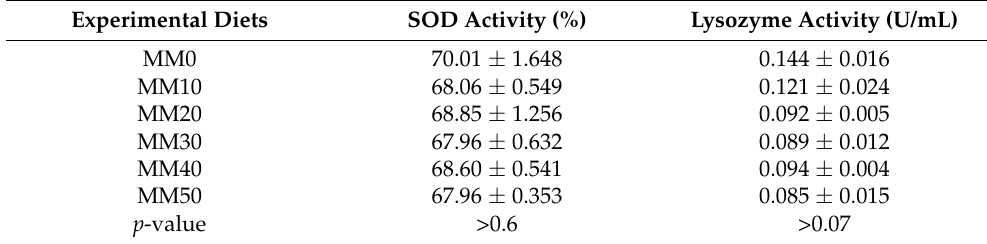
Table 7. Lysozyme activity and SOD of olive flounder fed the experimental diets for 56